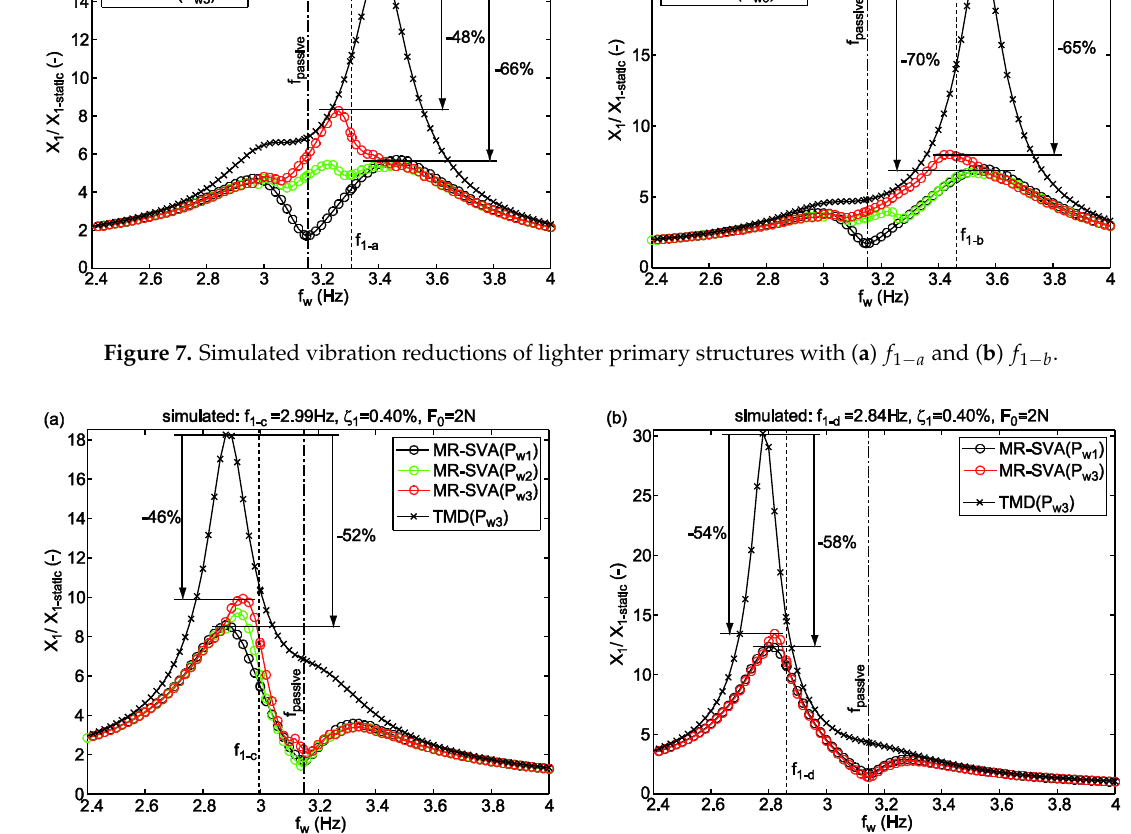
1 − c and ( b ) f 1 − d